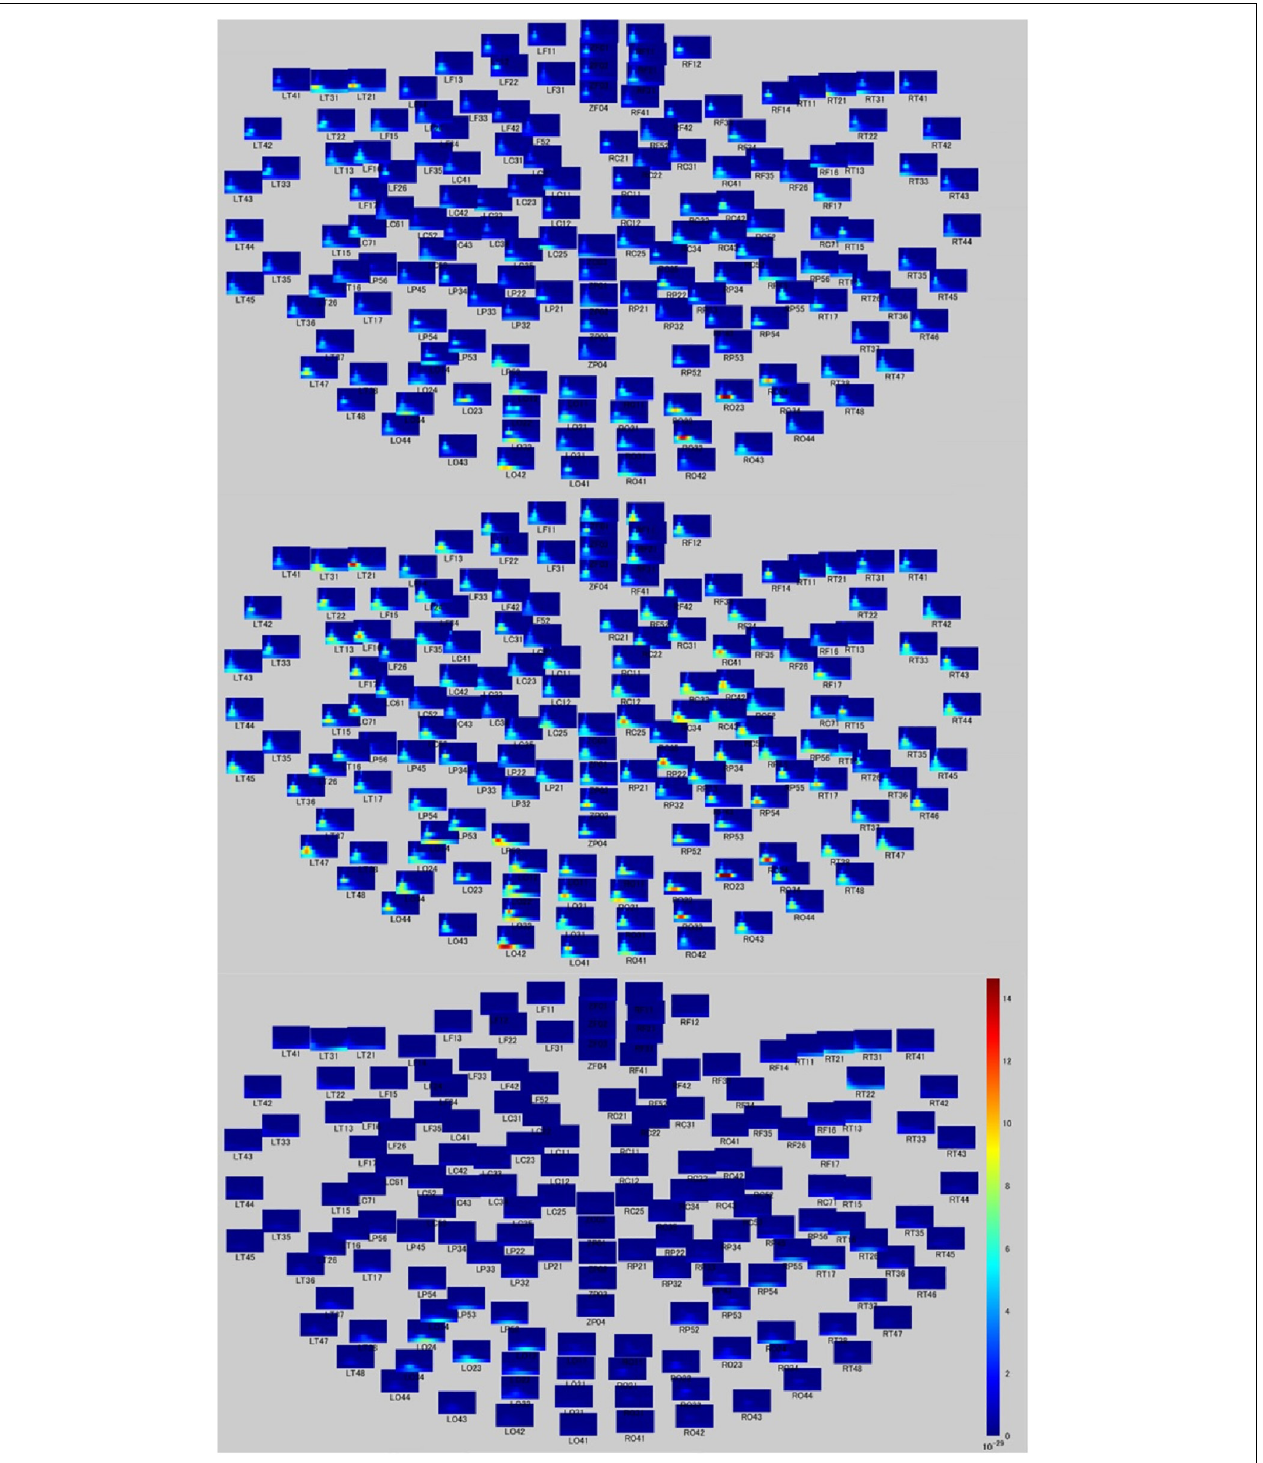
FIGURE 2 | Time-frequency relationship map during moral judgment. Time-frequency figures on whole head during MGJ (upper), MBJ (middle), and MNJ (lower) conditions. The X -axis of each small panel indicates the time from 200 ms before to 1,000 ms after a phase three picture presentation, and the Y -axis indicates the Hz from 0 to 120. The color bar denotes the power (signal units 2/Hz × 10–29) from 0 to 15.